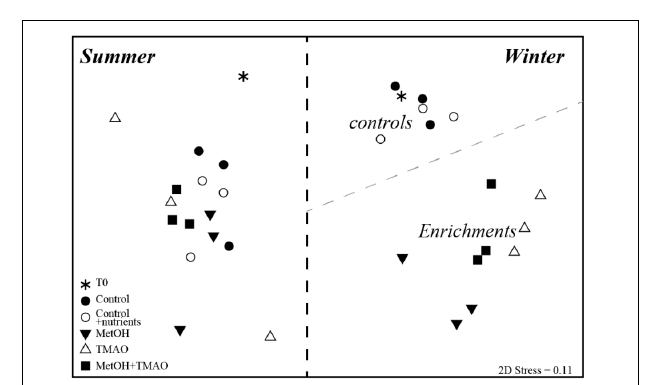
FIGURE 3 | nMDS clustering of bacterial community composition in winter and